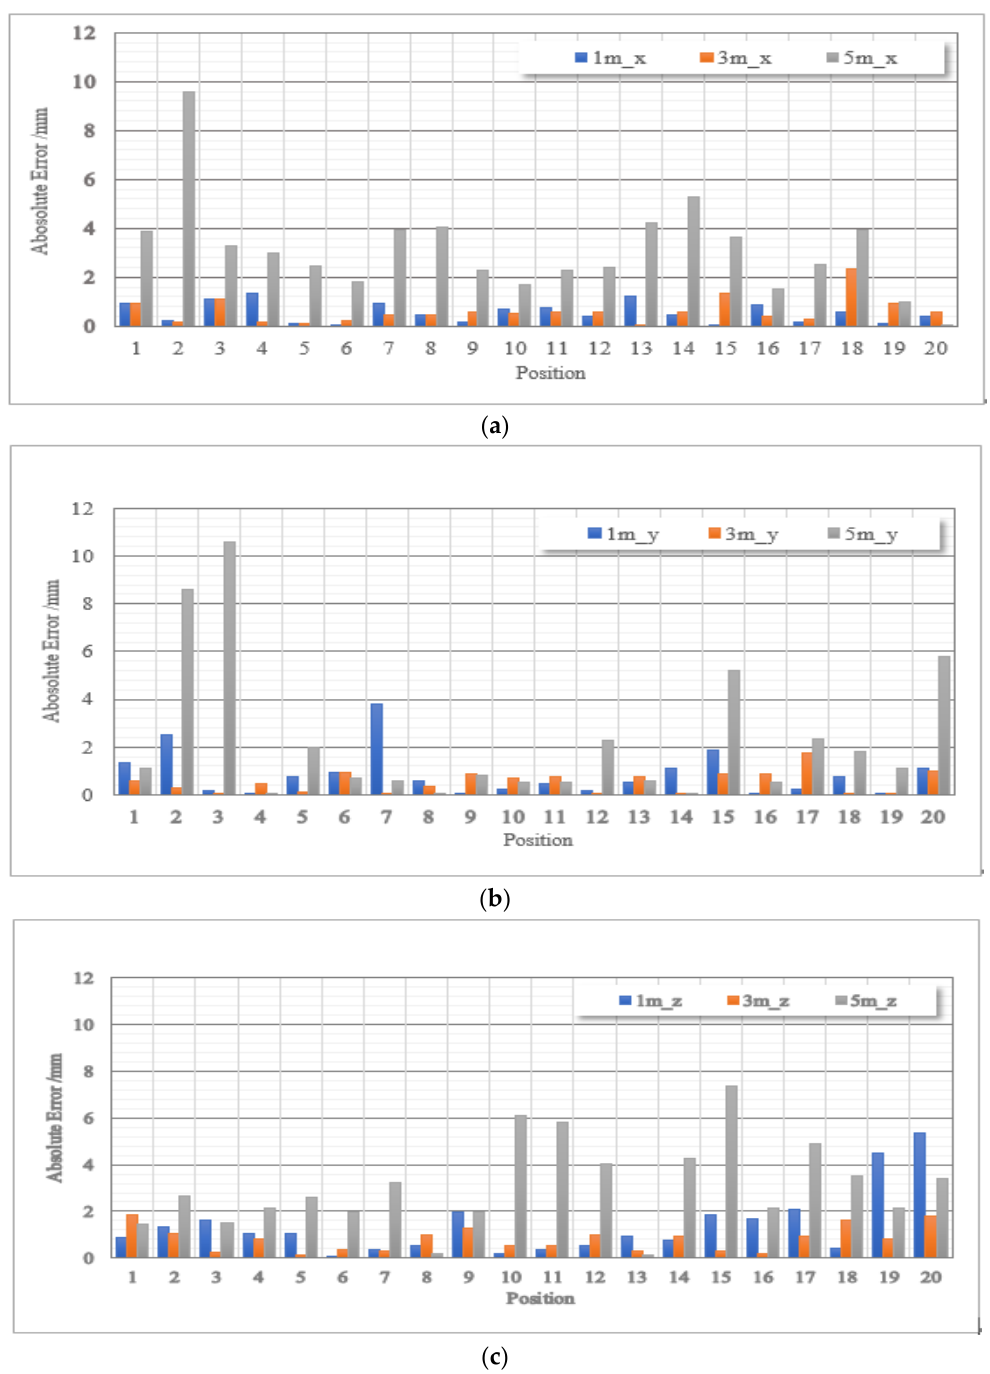
Figure 7. Average range error and at different distances (1 m, 3 m and 5 m). The blue bar refers to the result obtained when the tracker moves along the x -axis; the orange bar denotes to the result obtained along y -axis and the gray refers to the result obtained along the z -axis. ( a ) Average range error at 1 m away from the base stations; ( b ) Average range error at 3 m away from the base stations; ( c ) Average range error at 1 m away from the base stations.